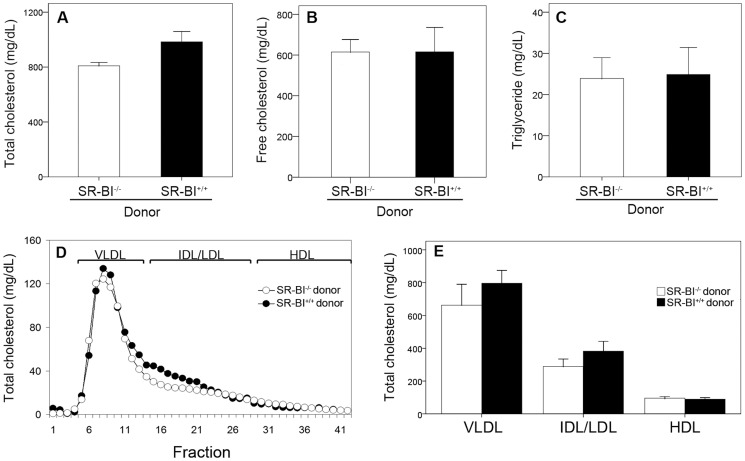
Restoration of SR-BI expression in BM derived cells did not alter lipids in HFCC diet fed SR-BI-null/apoE-hypomorphic mice.
A. Total cholesterol, B. unesterified (free) cholesterol and C. triglycerides were measured in plasma collected from fasted SR-BI−/− → SR-BI−/− (white bars) and SR-BI+/+ → SR-BI−/− mice (black bars) fed the HFCC diet for 3 weeks (n = 6 mice/group). D. Averaged lipoprotein total cholesterol profiles from n = 10 SR-BI−/− → SR-BI−/− (white symbols) and SR-BI+/+ → SR-BI−/− mice (black symbols) fed the HFCC diet for 3 weeks. Fractions corresponding to the elution of purified human VLDL, IDL/LDL and HDL are shown at the top. E. Total cholesterol fractions containing VLDL-sized (1–14), IDL/LDL-sized (15–28) and HDL-sized lipoproteins (29–42) from the lipoprotein total cholesterol profiles of individual mice were determined. Averages ± standard errors are shown (n = 10 mice/group). No statistically significant differences in values from SR-BI−/− → SR-BI−/− (white bars) and SR-BI+/+ → SR-BI−/− mice (black bars) were detected.